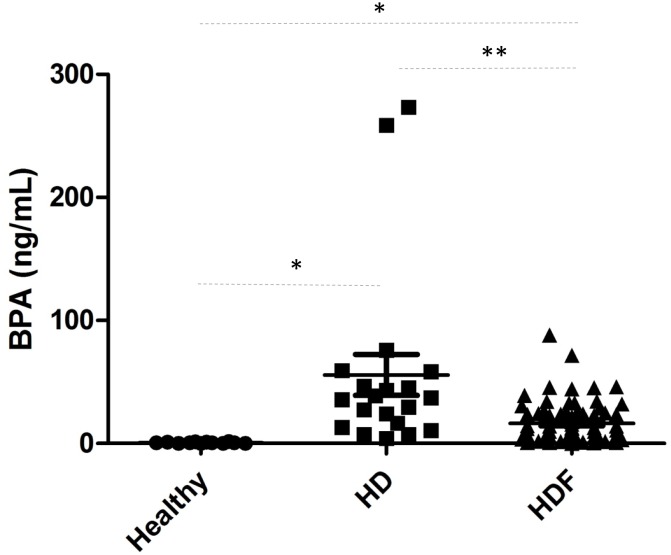
Plasma BPA concentration.Healthy subjects (n = 10); patients on online hemodiafiltration (HDF) (n = 58) and patients on conventional hemodialysis (HD) who were later enrolled in the present study (n = 18) [7]. Data expressed as mean±SD. For HD and OL-HDF, values correspond to baseline predialysis values in the switch studies. At this point, patients had been on HD or OL-HDF for >6 months. * p<0.05; ** p = 0.017.